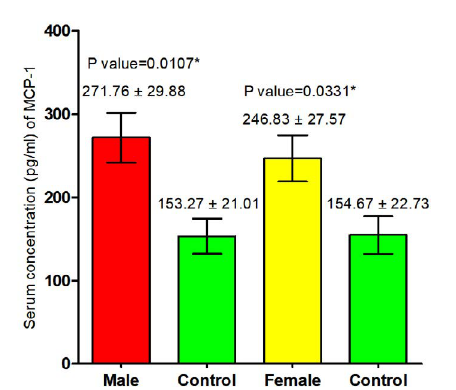
Fig. 6. Comparison between serum level of MCP-1 in total patients and total control with Sarcoptes